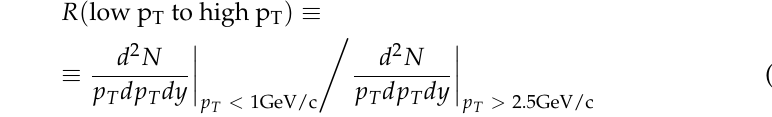
√ s NN = 2.76 TeV as a function